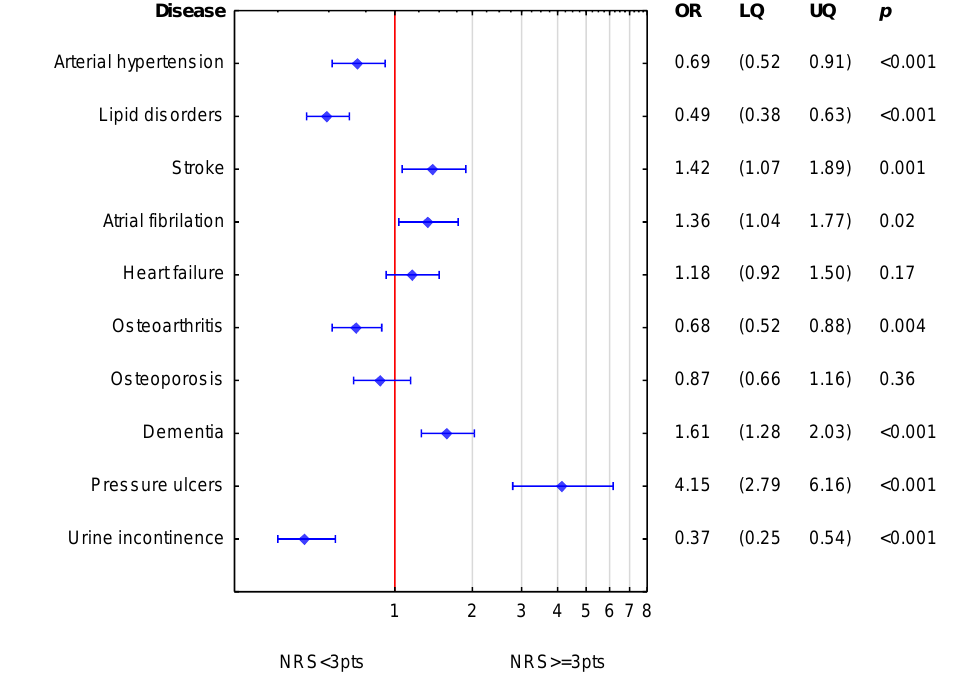
Nutrients 2023 , 15 , x FOR PEER REVIEW 7 of 15